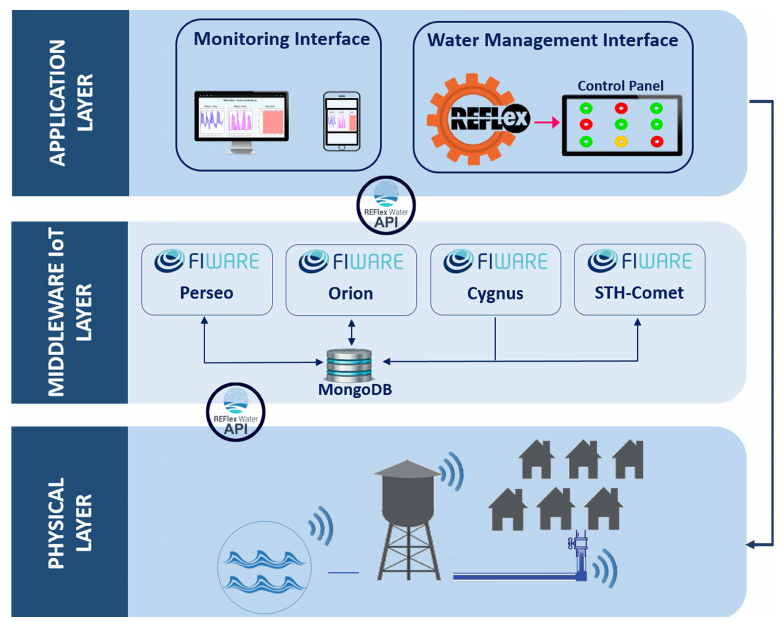
Figure 9. REFlex Water